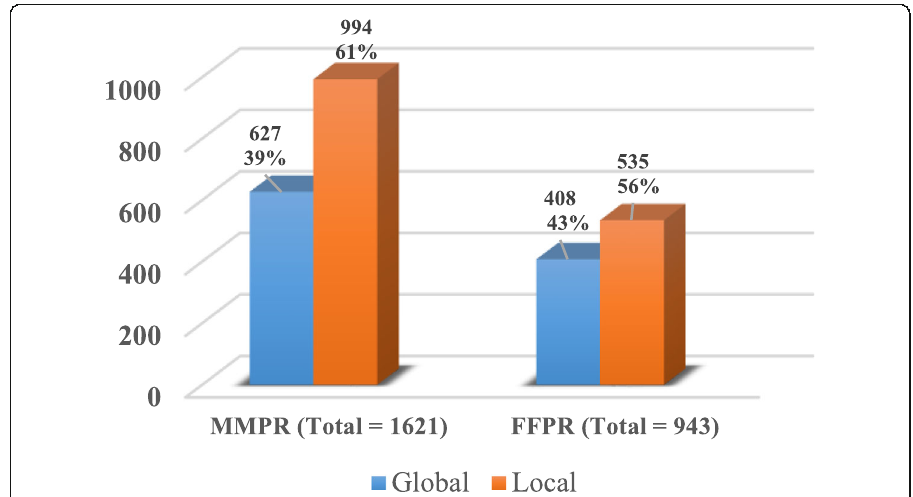
Fig. 2 Feedback distribution percentage by group and by area